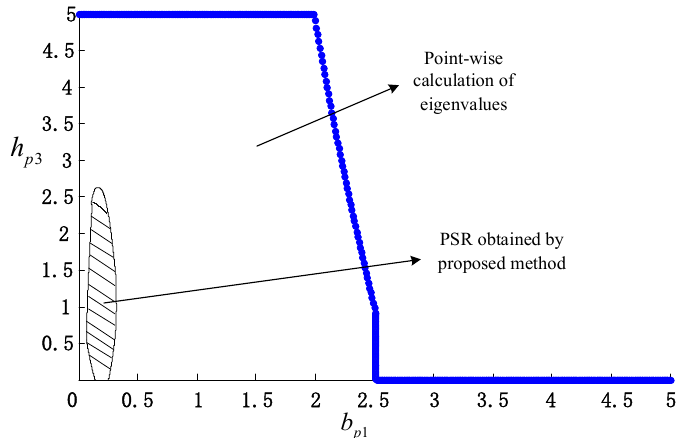
Figure 4. The PSR obtained by point-wise calculation of eigenvalues and proposed method. The system state matrix is related to the system operating status (power